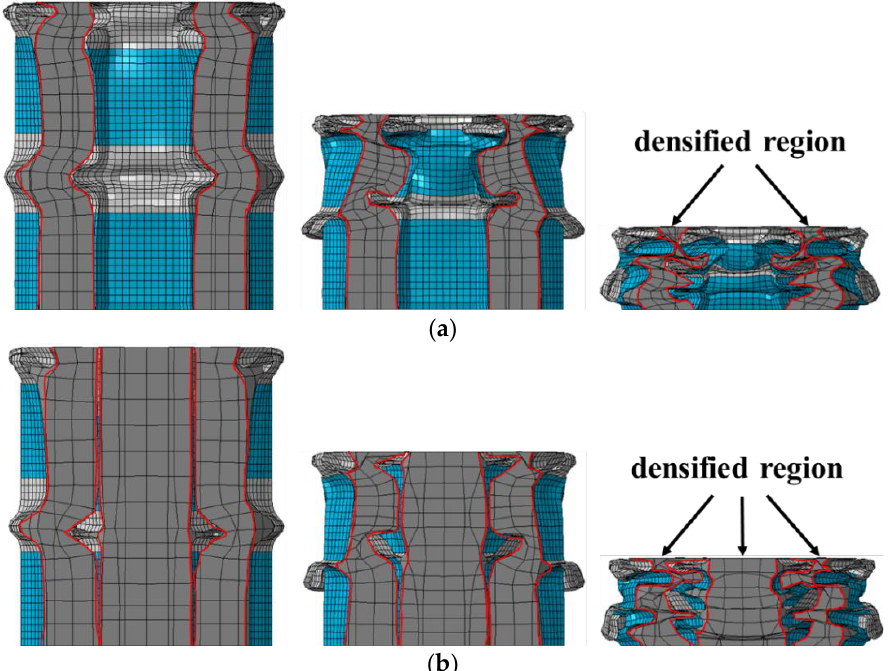
Figure 23. Load – displacement relation of FLNT and N-FLNT-4.